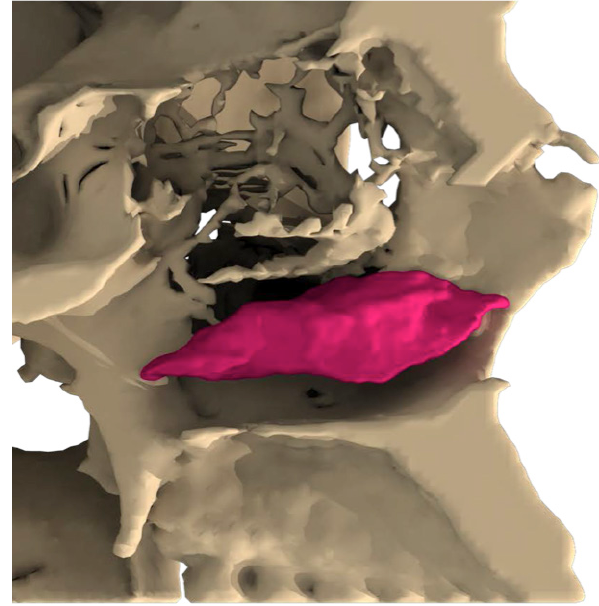
Figure 5. 3D reconstruction of average shape for women inferior turbi- nate between 30 and 60 years (medial